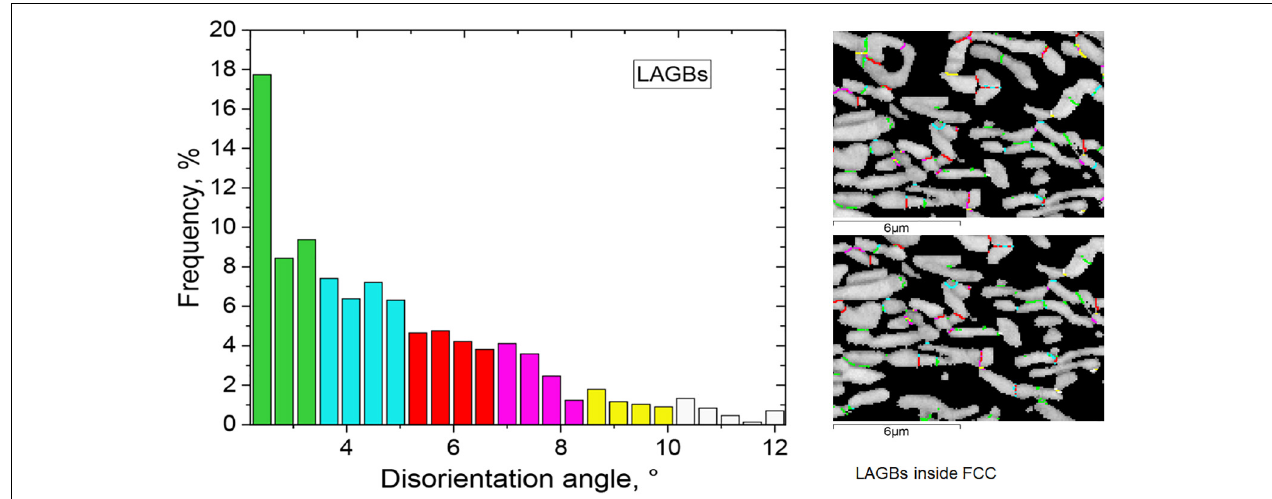
FIGURE 7 | Disorientation angle distribution inside the vermicular FCC phase of grain 2 (compare Figures 3B,C ) in the range from 2 to 12 ◦ and associated sub-grain boundaries, i.e., low angle grain boundaries